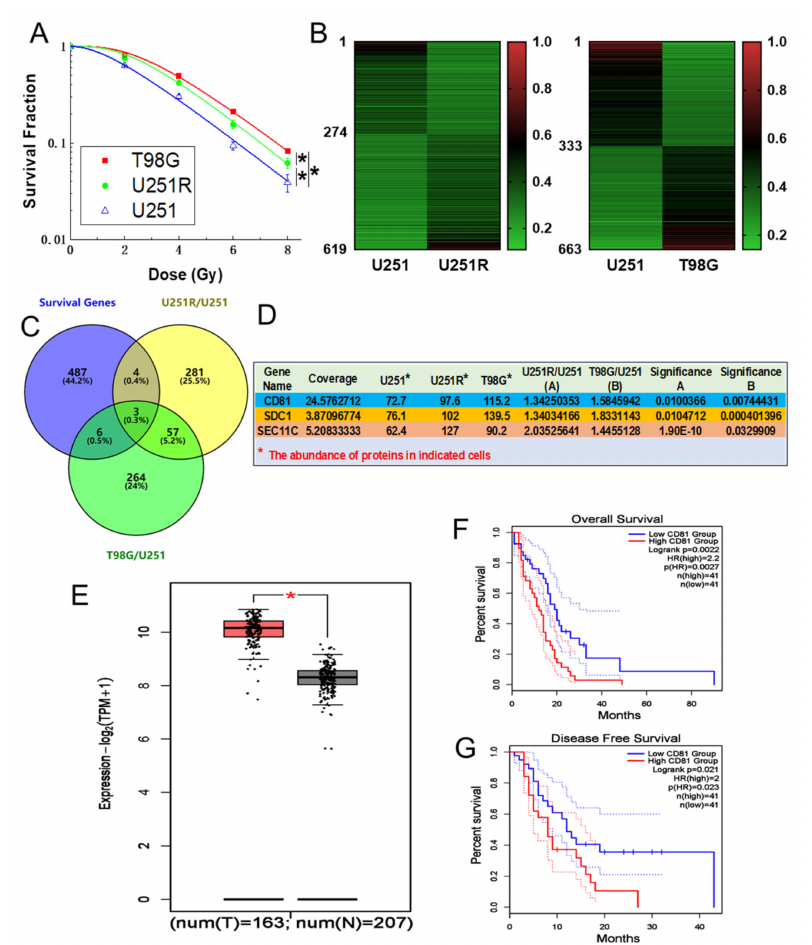
Figure 1. CD81 had close relevance with GBM in clinic. ( A ) Clonogenic survivals of T98G, U251R, and U251 cells exposed to 0, 2, 4, 6, and 8 Gy of X-rays. ( B ) Heat maps of the differential expression genes between U251 and U251R cells (left), T98G and U251 cells (right) (fold change ≥ 1.2, p < 0.05). ( C ) Wayne chart of the overexpressed genes in U251R and T98G cells in comparison with U251 cells, which significantly impacted the prognosis of GBM patients ( p < 0.05). The intersection contained three genes. Yellow and green parts represented the upregulated genes in U251R and T98G cells, respectively. Blue part represented the survival-related genes of GBM patients (data from GEPIA). ( D ) The expression levels of above three genes in U251, U251R, and T98G cells. ( E ) Average level of CD81 in 163 GBM tissues (T) and 207 normal tissues (N) based a GEPIA database. ( F ) Kaplan–Meier analysis of the relationship between CD81 expression and overall survival (OS) of GBM patients (data from GEPIA). ( G ) Kaplan–Meier analysis of the relationship between CD81 expression and disease-free survival (DFS) of GBM patients (data from GEPIA). *, p < 0.05 between indicated